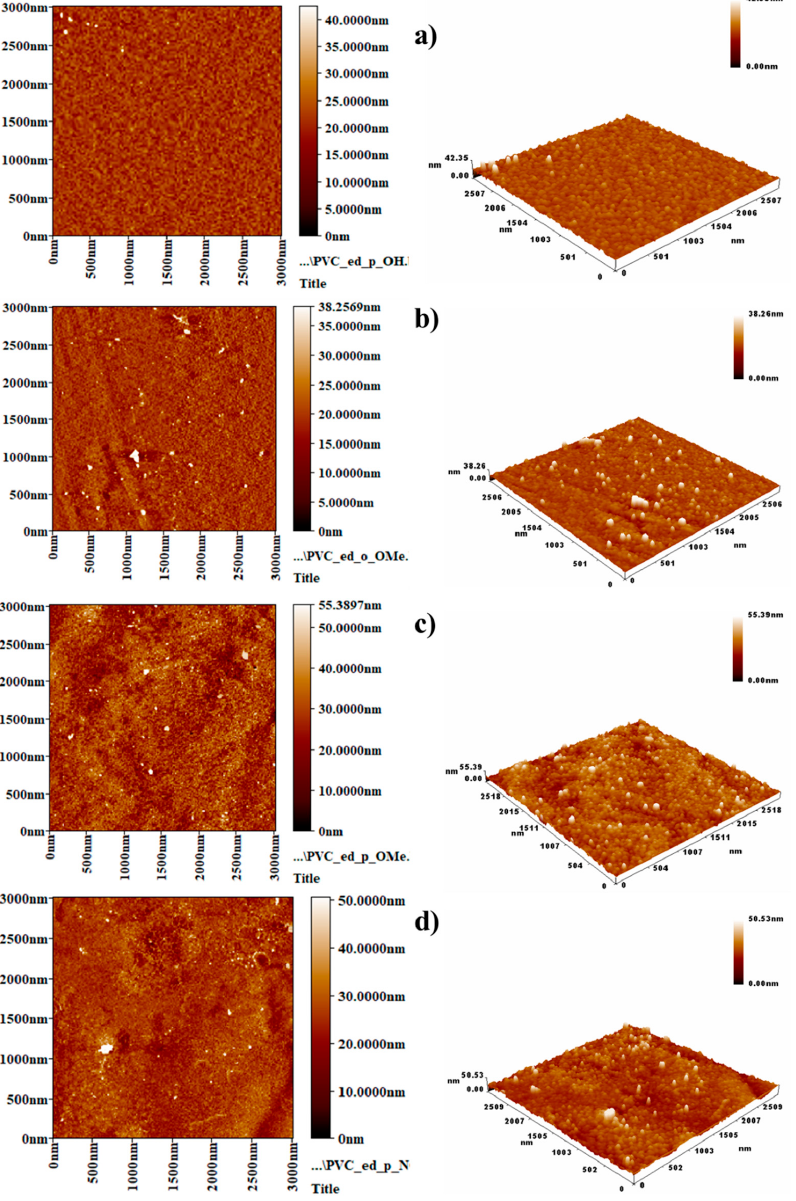
Figure 15. AFM images after irradiation of doped PVC with ( a ) PVC-ed/p-OH , ( b ) PVC-ed/o-OMe , ( c ) PVC-ed/p-OMe , ( d ) PVC-ed/o-NO 2 .